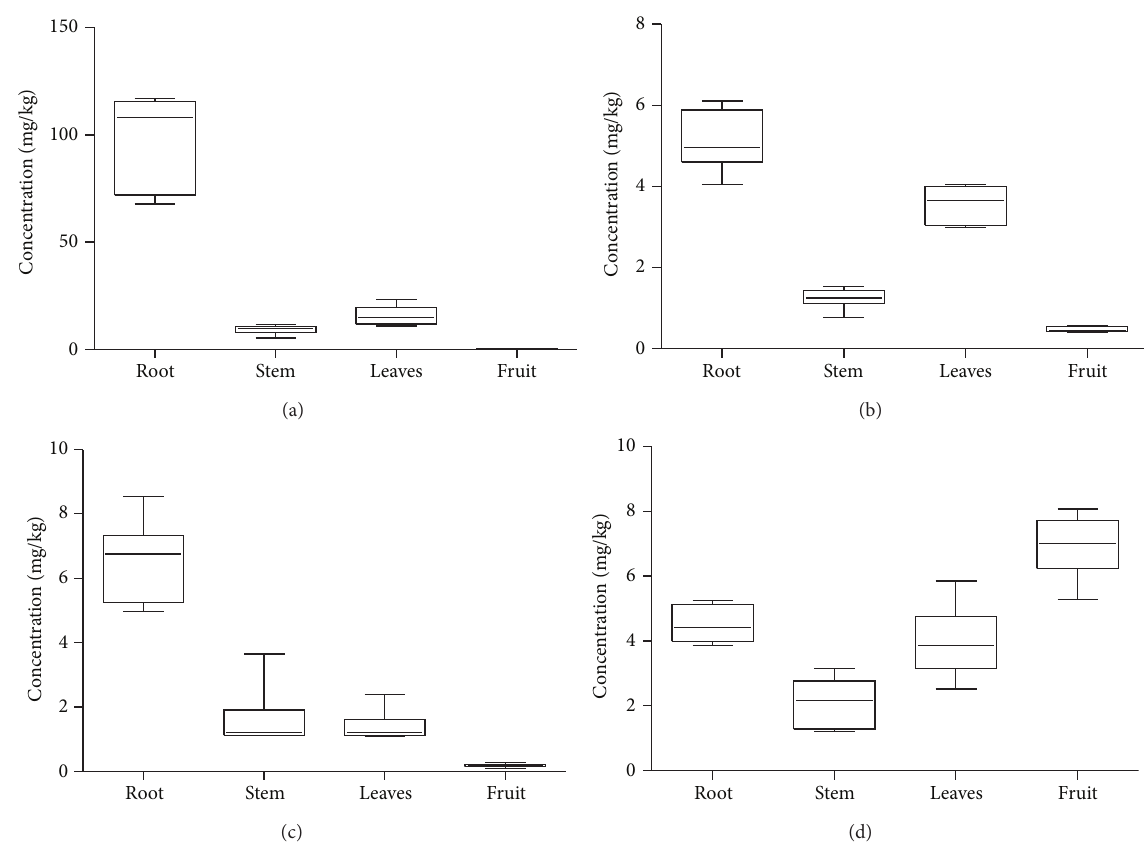
Figure 3: Heavy metal concentrations in the roots, stems, leaves, and fruit of maize. (a) Cr; (b) Pb; (c) Ni; (d) Zn.